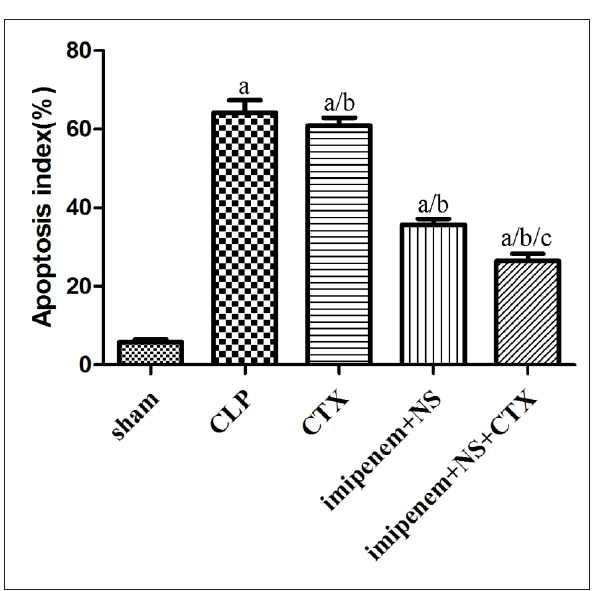
Fig. 6. The levels of serum FD-70 and expressed as mean ± SD ( P <0.05). Compared to the sham group, there was statistically signifi- cant difference ( P <0.05); Compared to the CLP group, there was statistically significant difference ( P <0.05); Compared the imipenem+NS group with the imipenem+NS+CTX group, there was statistically significant difference ( P <0.05).